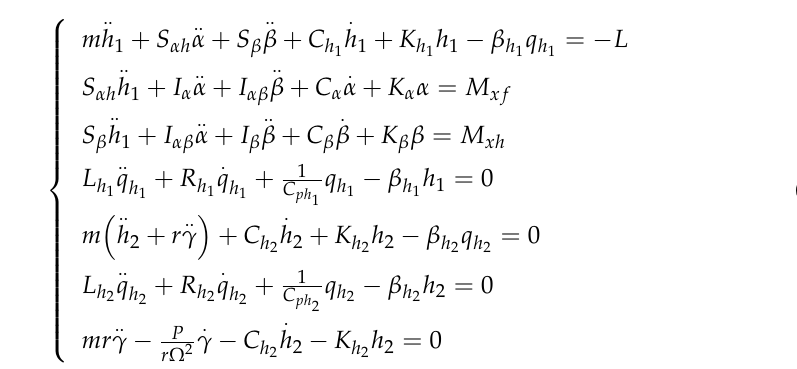
Figure 9. A smart blade with plunge, pitch, and control DOFs and a piezopatch in flapwise plunge DOFs.